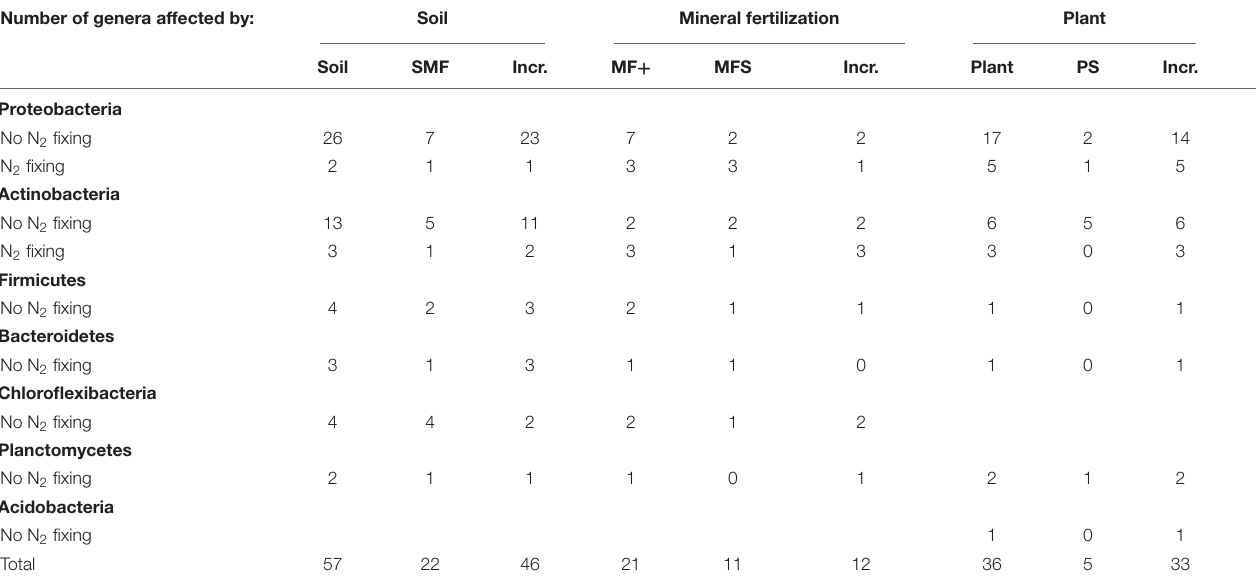
TABLE 6 | Number of genera from the 100 most abundant genera of bacteria affected by soil type (compost addition), mineral fertilization, and presence of plant (olive saplings). Number of genera affected